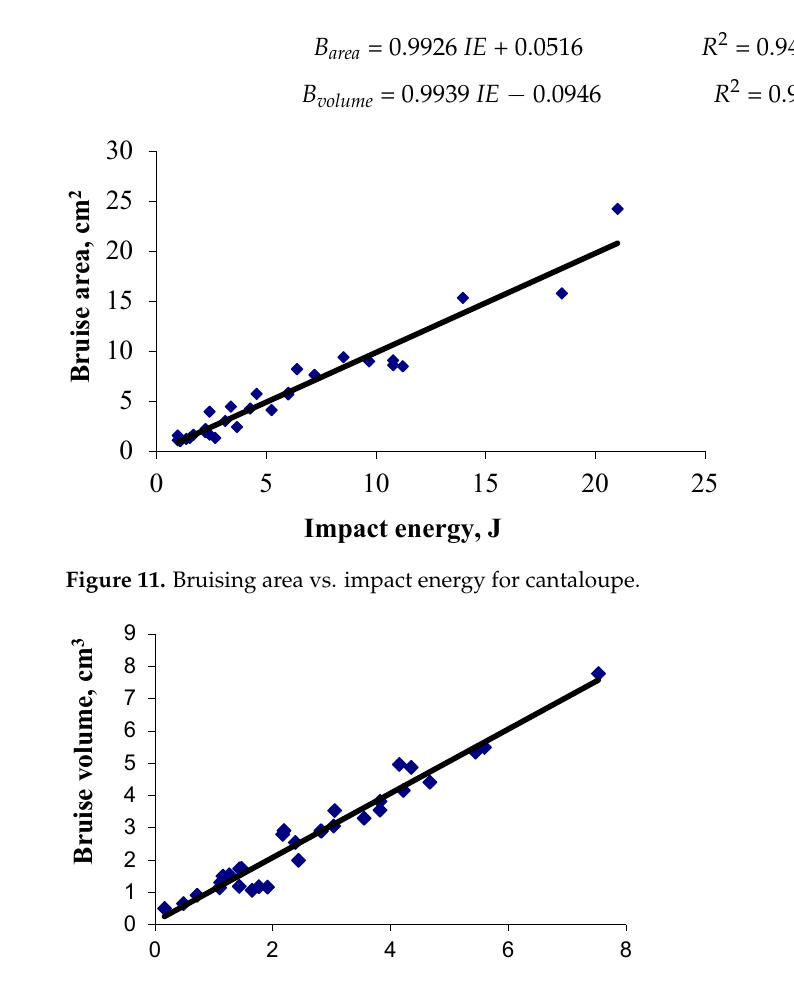
Figure 12. Bruise volume vs. impact energy for cantaloupe.